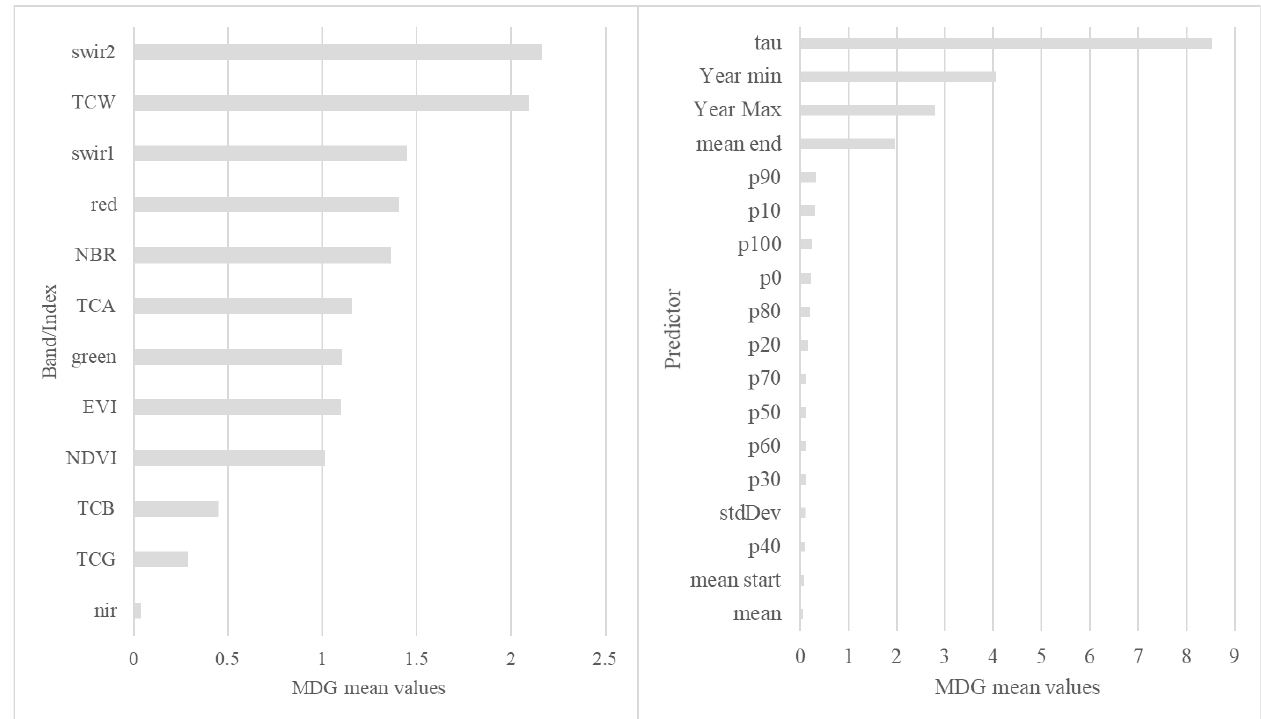
Figure A1. Temporal predictors importance ranking for the classification approach. In the figure are illustrated mean values of the Mean Decrease Gini Index for each band, index and predictor.